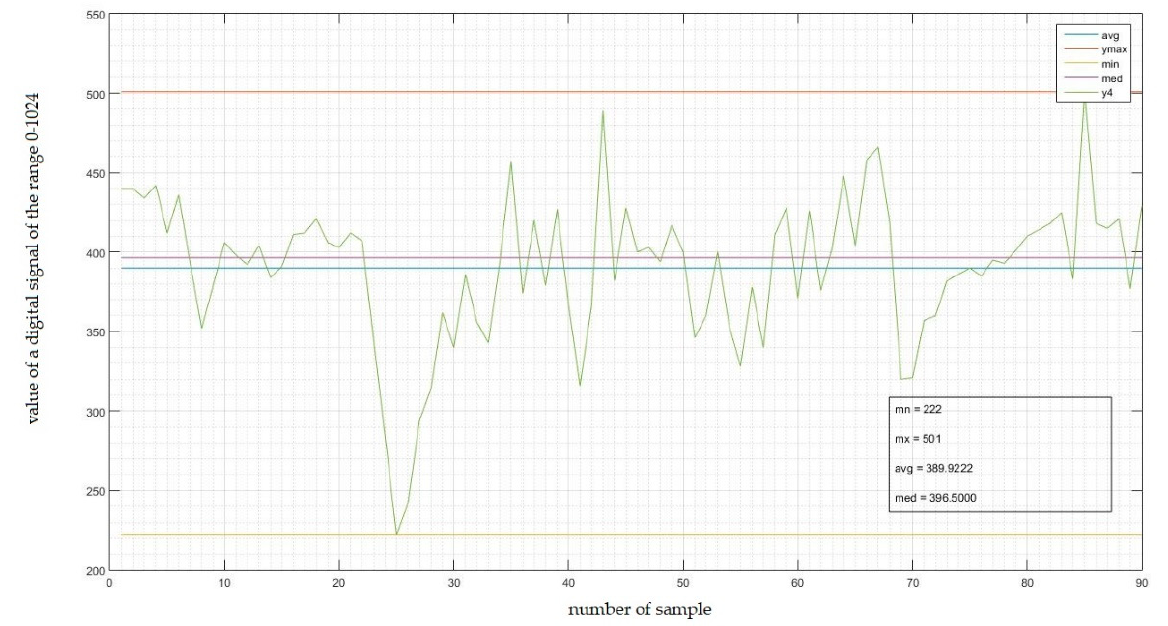
Figure A9. Data from the sensor on a maximally bent little finger.